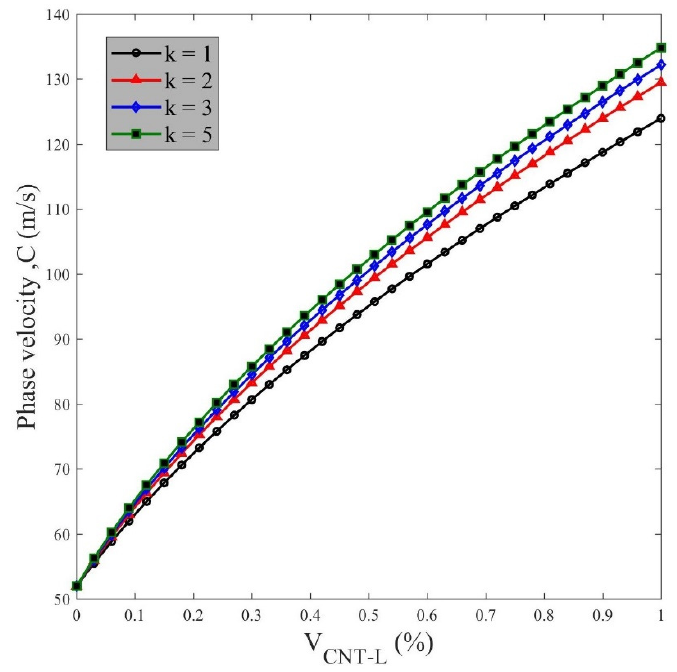
k . Figure 12. Phase velocity vs. V CNT − L for different k